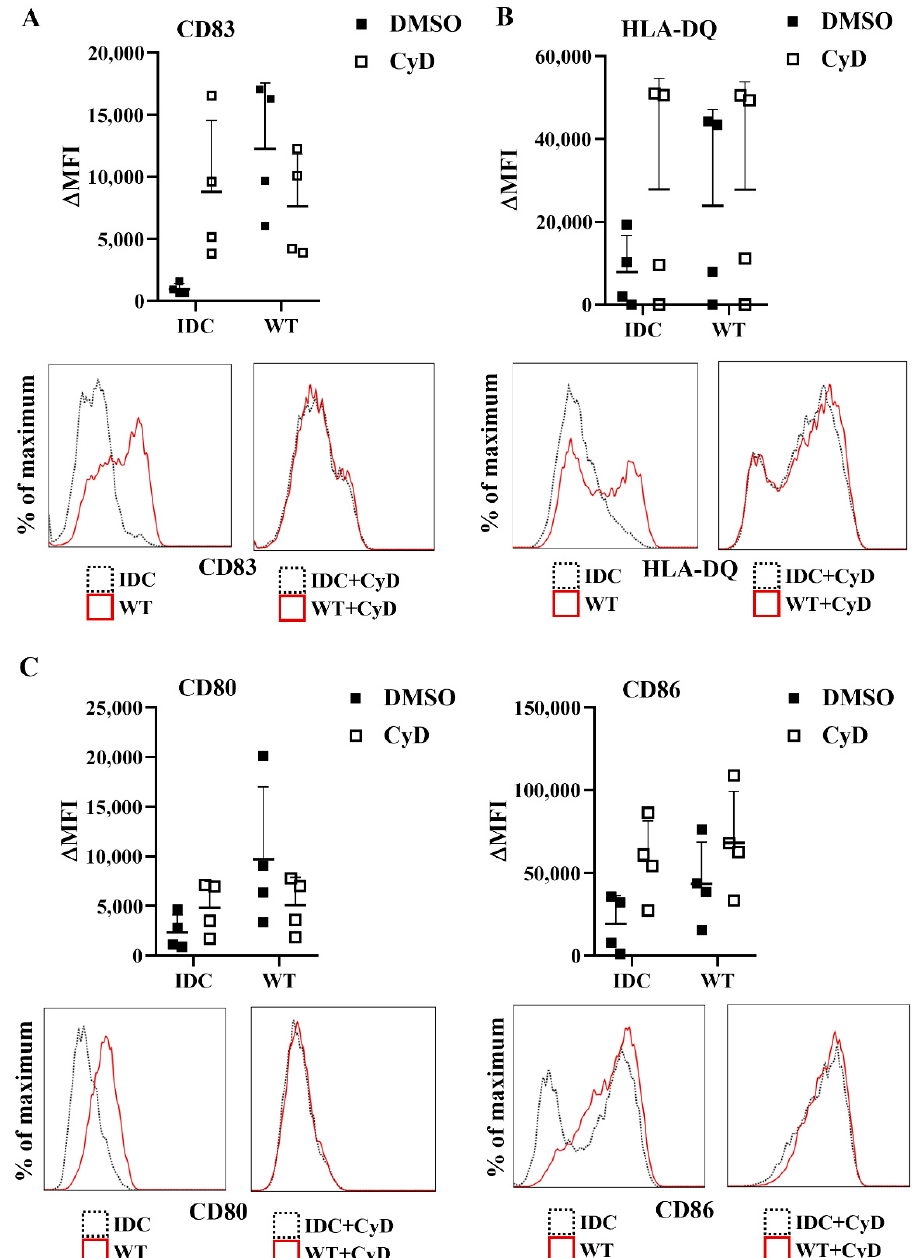
Figure 9. Cytochalasin D pretreatment does not cause alterations in the expression of activation and costimulatory markers of moDCs. Five-day moDCs were preincubated with 15 µ M CyD or its vehicle control DMSO for 30 min. Then, moDCs were stimulated with WT L. casei BL23 at a ratio of 1:4 for 24 h. Expression of CD83 ( A ), HLA-DQ ( B ), and costimulatory CD80 and CD86 ( C ) molecules was measured by flow cytometry. IDC represents cells without any bacterial treatment. Median fluorescent intensities ( ∆ MFI) were calculated from 4 independent experiments ± SD. Histogram overlays show one representative experiment. Each dot is representative of one donor.